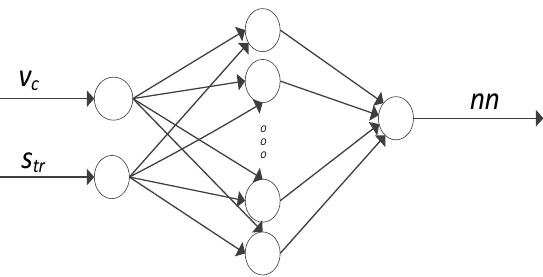
Figure 2. Schematics of the artificial neural network with the analysed process parameters